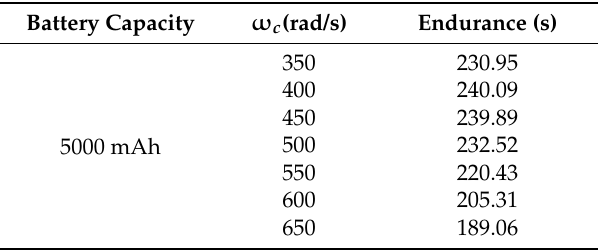
Table 3. The endurance performance versus rotational